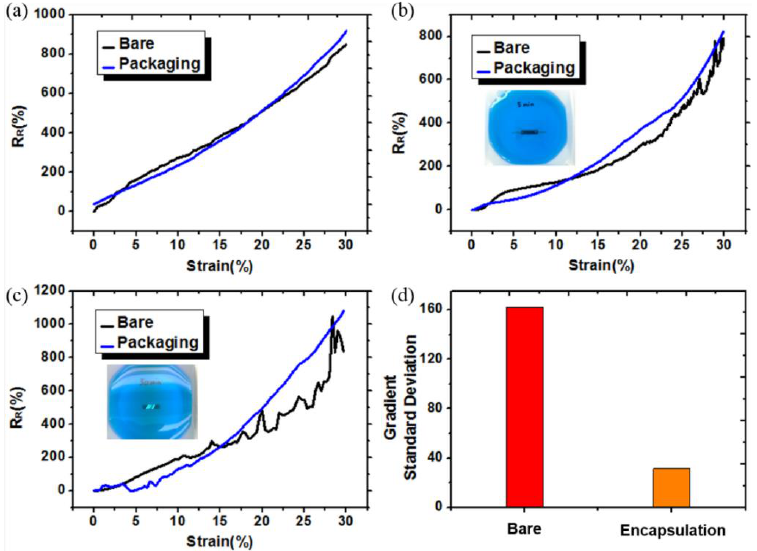
Figure 4. ( a – c ) Change in R R value of a bare and an OLE sensor according to the water-exposure time (0, 5, and 50 min, respectively); and ( d ) comparison of the slope standard deviation after 50 min exposure in water.